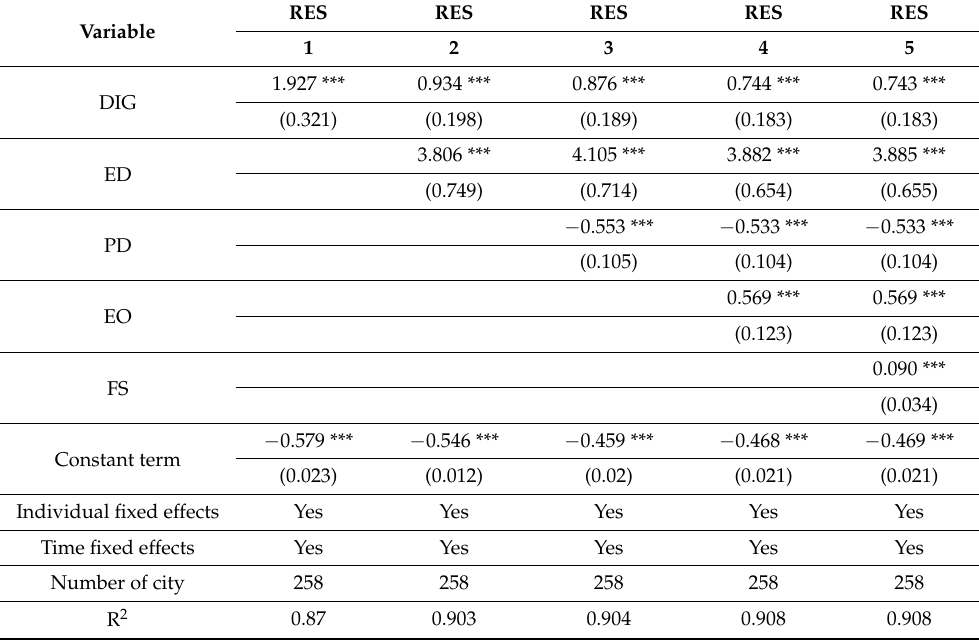
Table 3. Results of benchmark